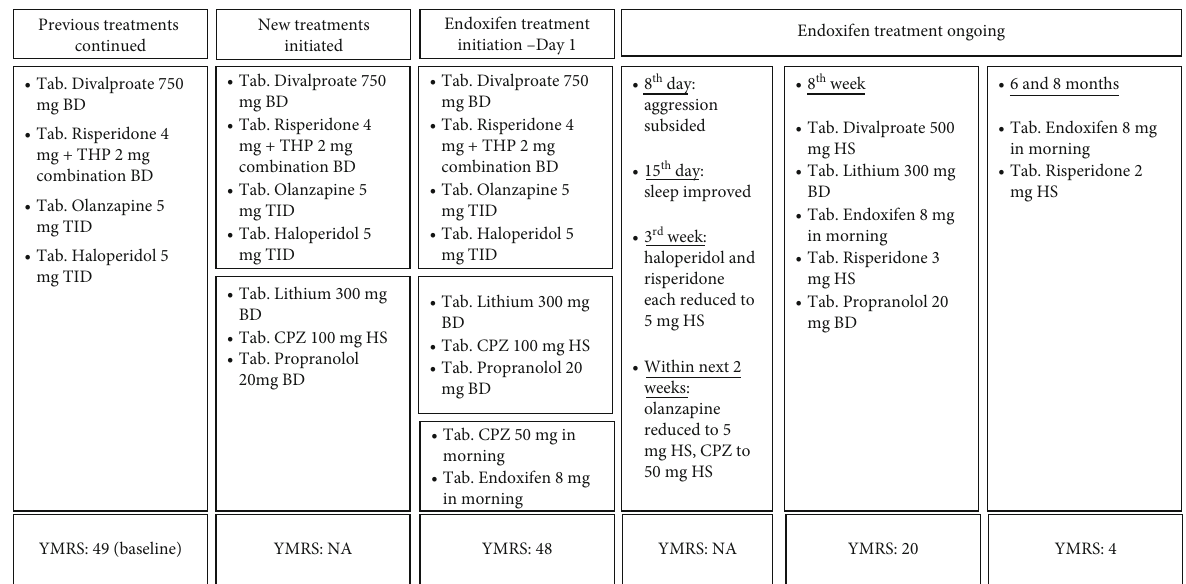
Figure 1: Treatment